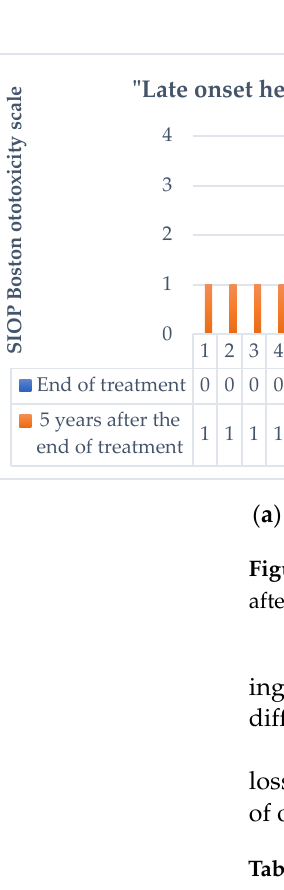
Table 3. Comparison between patients with late-onset hearing loss/progressive hearing loss and patients with stable hearing at the end of the 5 years of